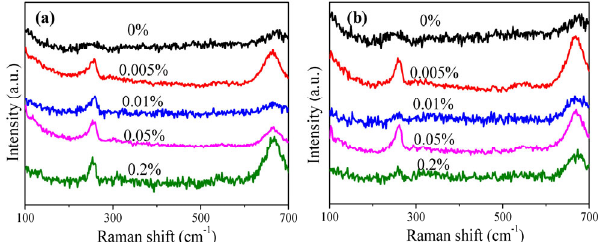
Fig. 10 Raman spectra of the rubbed surfaces lubricated by PAO6 containing different mass concentrations of nanocomposites under the load of 20 N: (a) TiO 2 /BP and (b) TiL 4